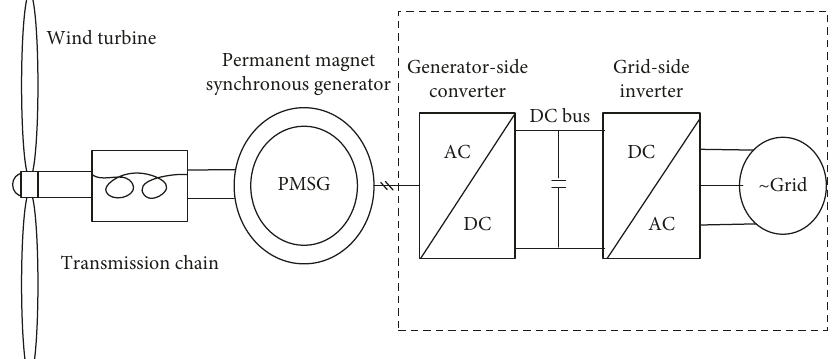
Figure 3: Structure diagram of WECS.